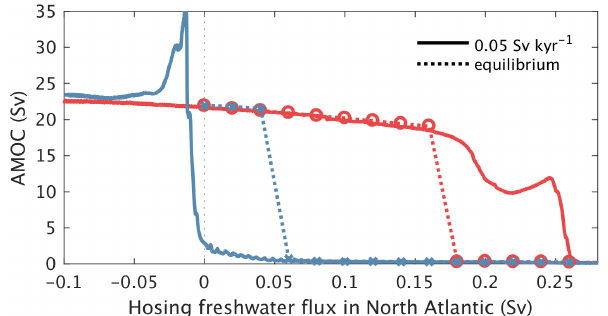
Figure 32. AMOC hysteresis for freshwater hosing applied to the latitudinal belt between 20 and 50 ◦ N in the Atlantic. The hysteresis curve for experiments where the freshwater hosing is changed at a rate of 0.05Sv per 1000 years is shown by the solid lines. The sym- bols and the connecting dotted lines indicate the AMOC strength for quasi-equilibrium simulations with a prescribed constant fresh- water hosing rate initialized from an AMOC on state (red circles) and from an AMOC off state (blue crosses).